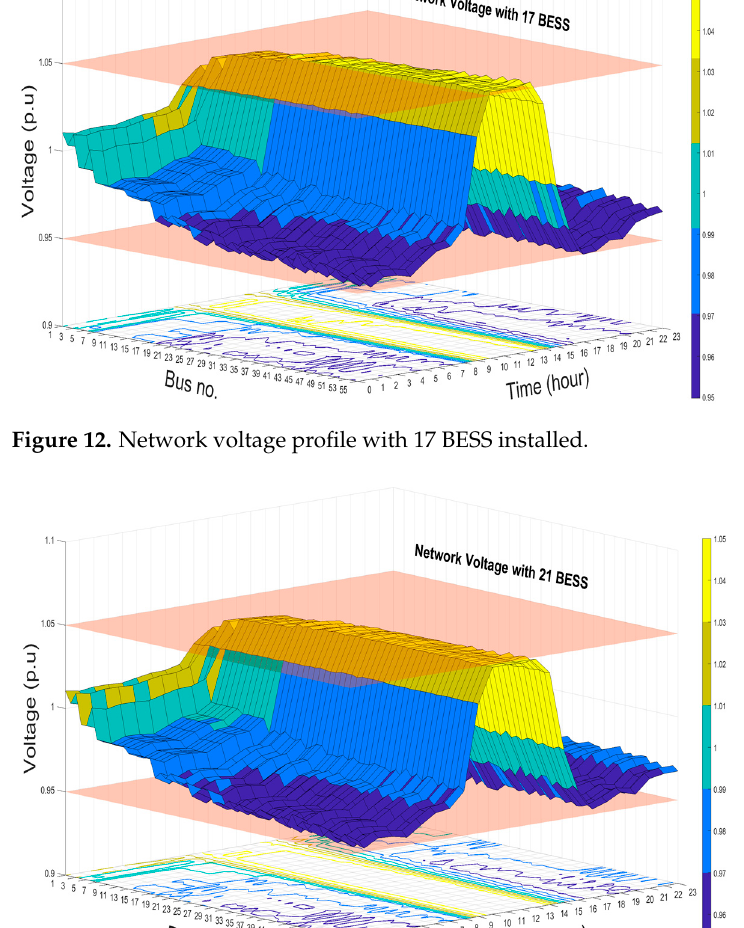
Figure 13. Network voltage profile with 21 BESS installed.